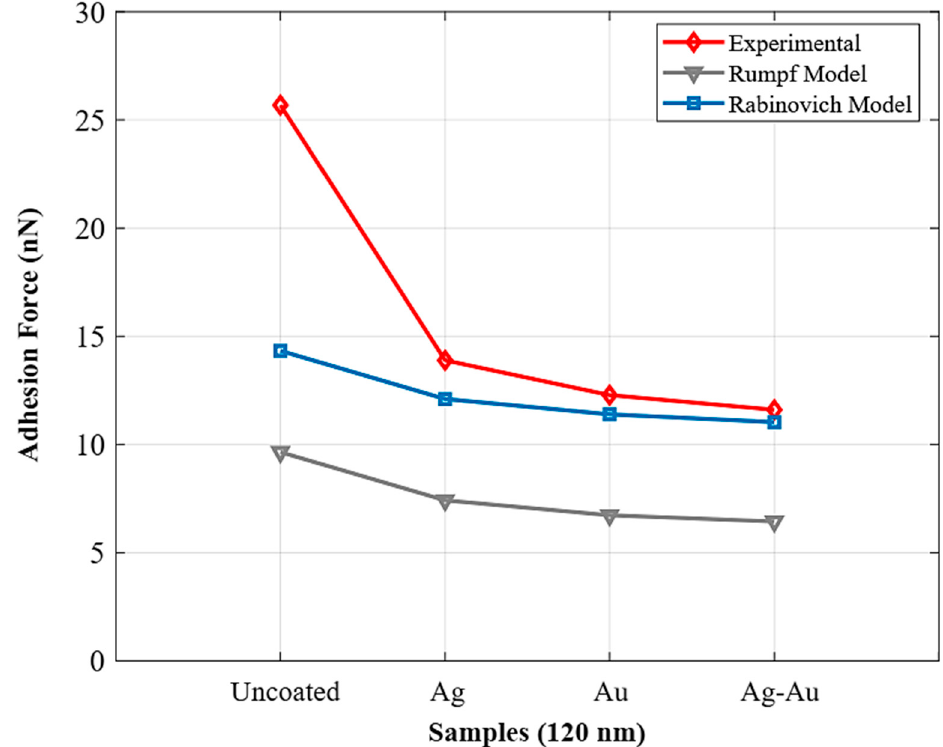
Figure 9. Comparison of adhesion force values between theoretical and experimental approaches to samples with 120 nm thickness.